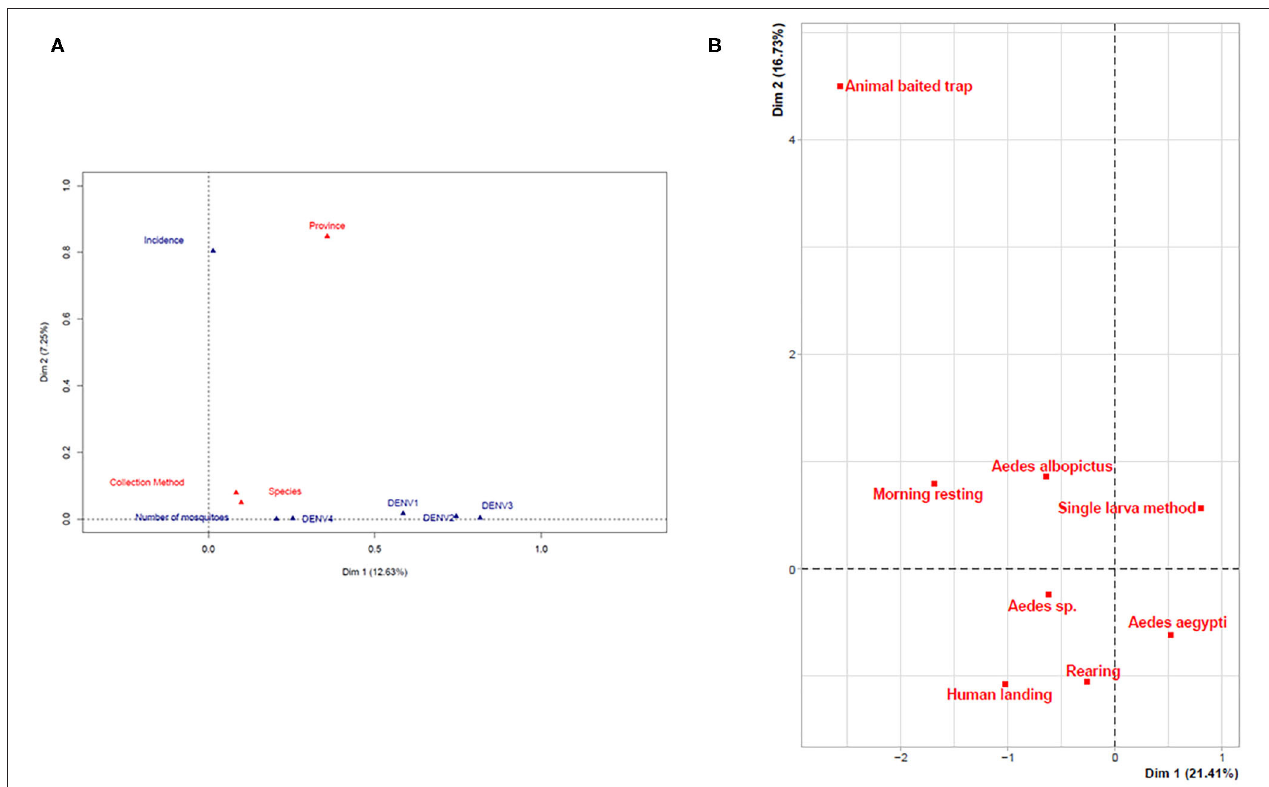
FIGURE 2 | Multivariate analysis of parameters. (A) Global factor analysis of mixed data. (B) FAMD assessment of the effectiveness of the collection